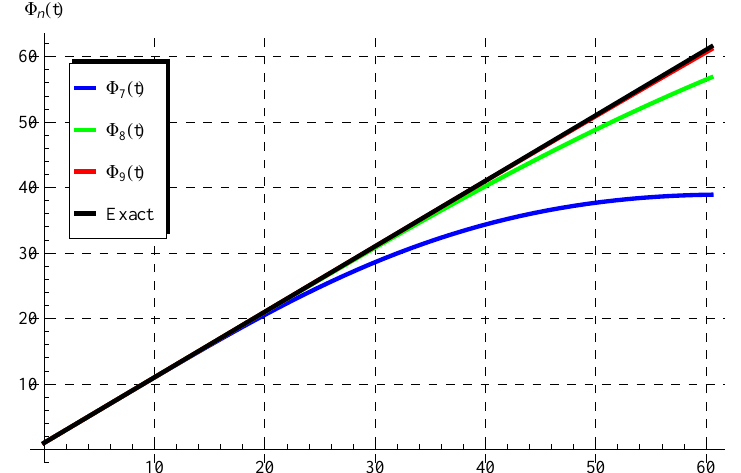
Figure 1. Comparisons between the approximate solutions Φ n ( t ) , n = 7,8,9 in Equation (67) and the exact solution in Equation (68) at a = − 1, b = 2, c = 1/2.